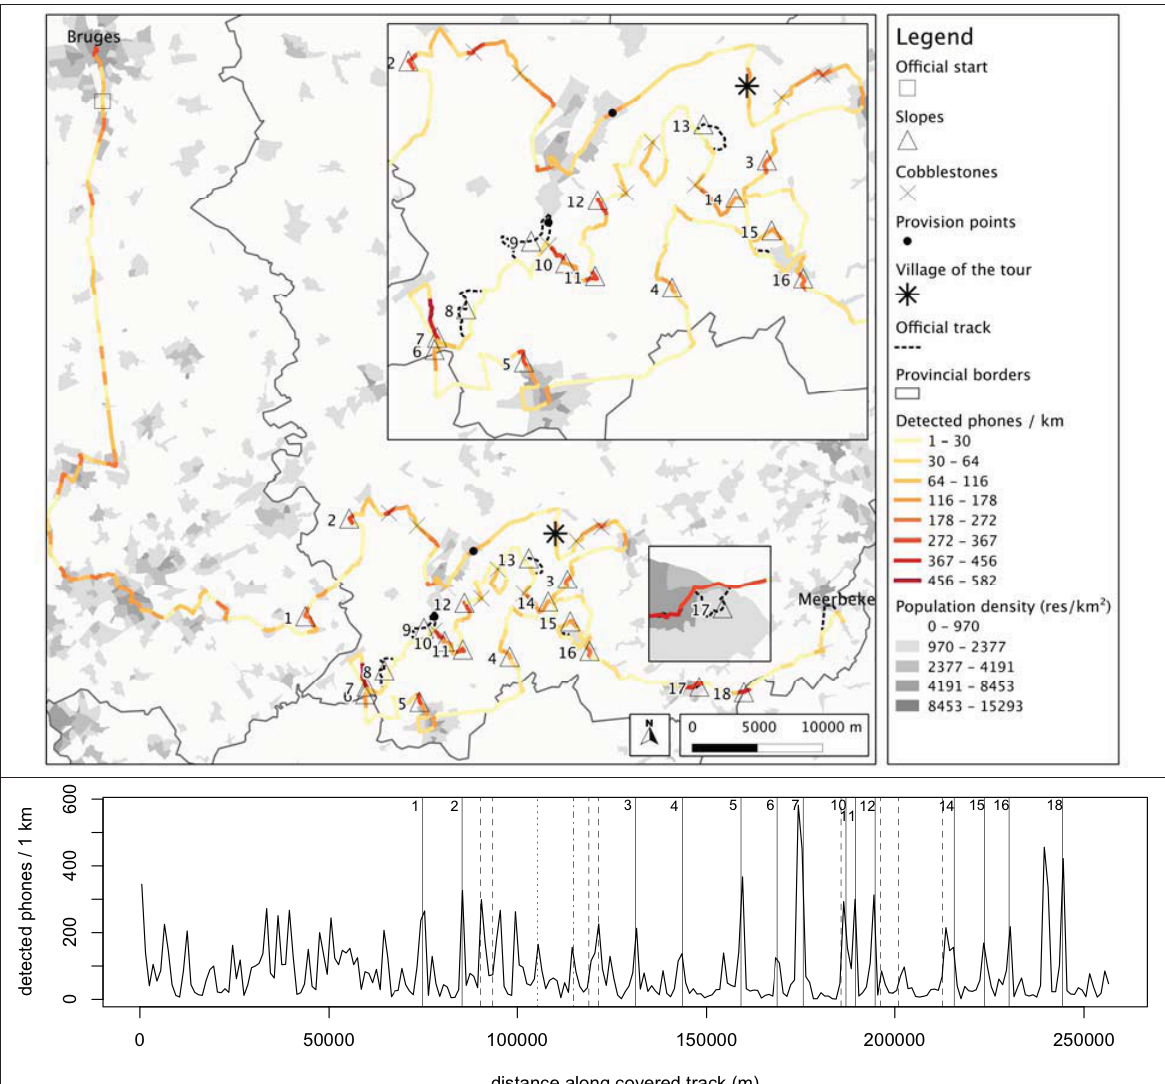
Figure 4. Number of detected phones along 1 km long segments of the trajectory followed by the mobile platform as an indicator of crowdedness. Top: spatial view using a yellow- to-red color scale to depict the number of phones, class breaks according to the Jenks natural breaks optimization [32]. The background shows the population density of statistical sectors in the area, colored in a grey-scale, once again according to Jenks natural breaks. Bottom: one-dimensional